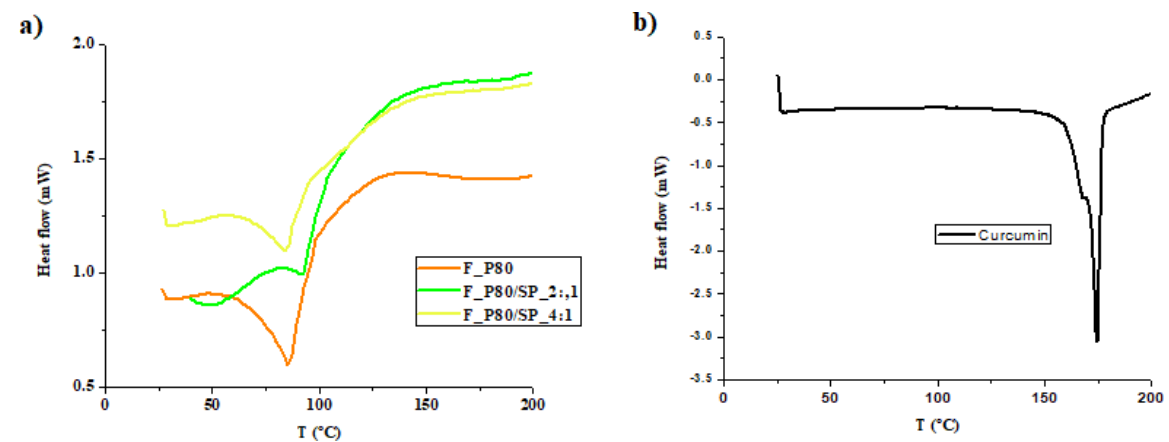
Figure 4: Differential scanning calorimetry thermograms of the curcumin nanocrystal dispersions (a) and bulk curcumin